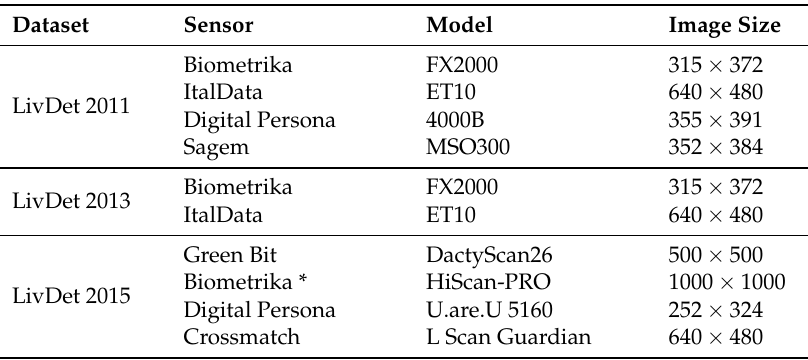
Figure 8. Sample images of LivDet 2015. The top row includes live samples; the bottom row includes fake samples. Samples are from Biometrika ( a ), Crossmatch ( b ), Digital Persona ( c ) and Green Bit ( d ) devices. Table 2. Summary of the datasets used in the experiments